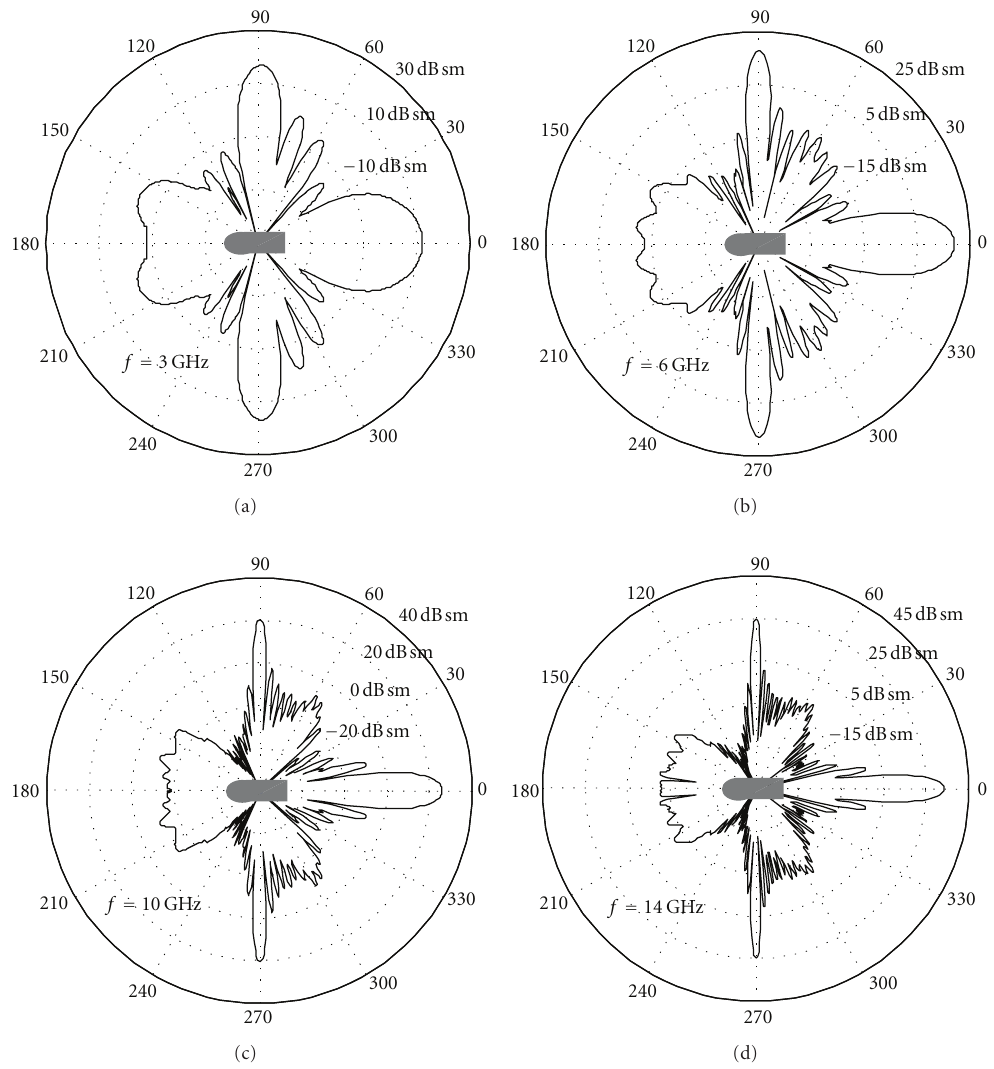
Figure 11: Monostatic RCS of the projectile at 3GHz, 6 GHz, 10GHz, and 14 GHz as a function of θ .